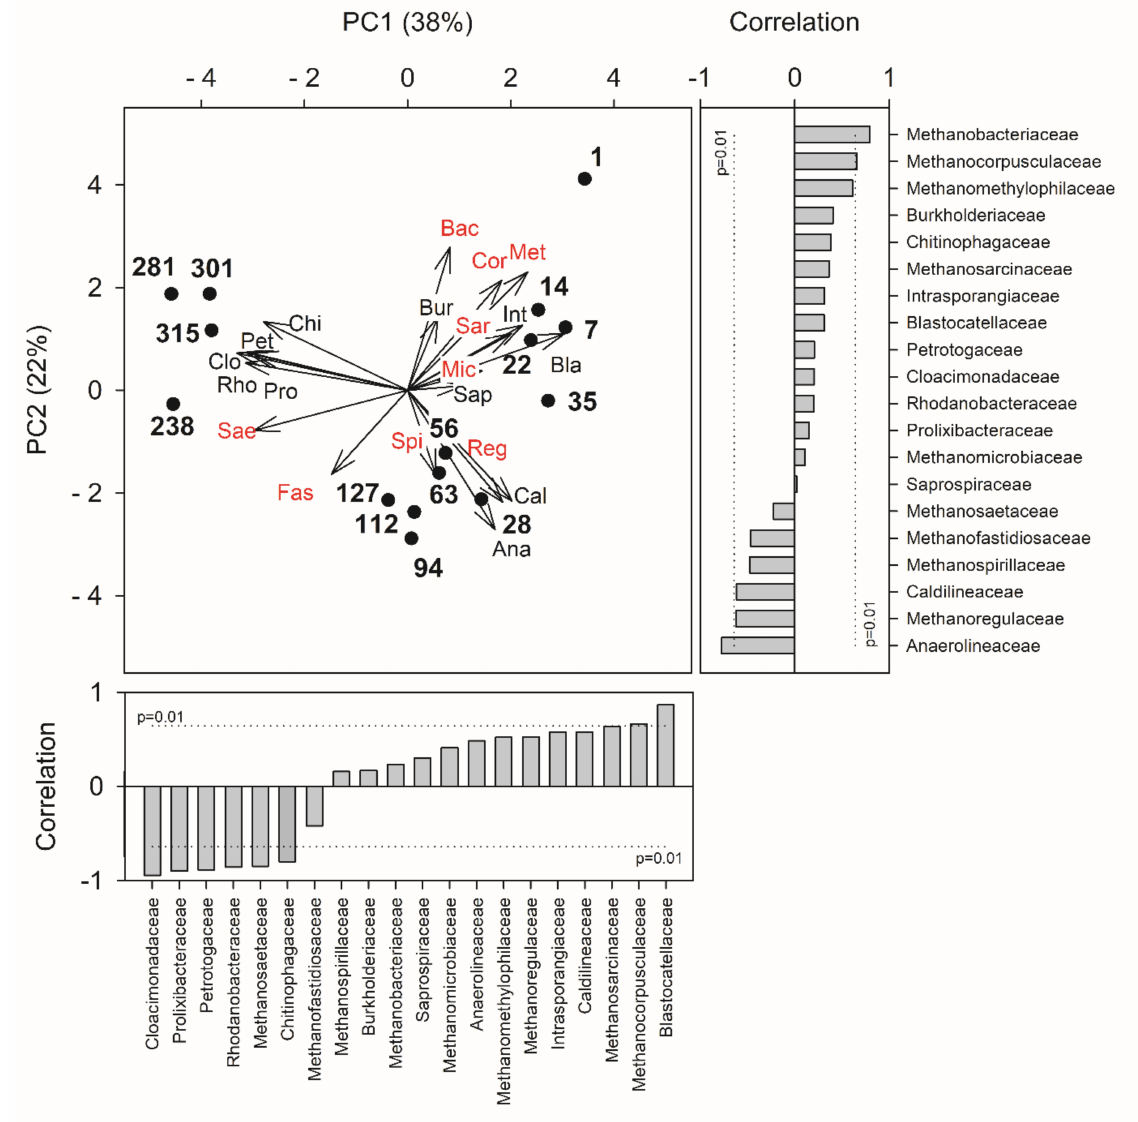
Figure 7. Principal components analysis biplot performed using bacterial (in black) and archaeal (in red) families (>5%) as revealed by 16S rRNA gene high-throughput sequencing. The vector length is proportional to the correlation between the corresponding parameter and the PCA axis 1 and 2. Histogram plots show the contribution of each variable (vector projection values) expressed as the correlation with the x- and y-axis (PC, Principal Component). Ana,